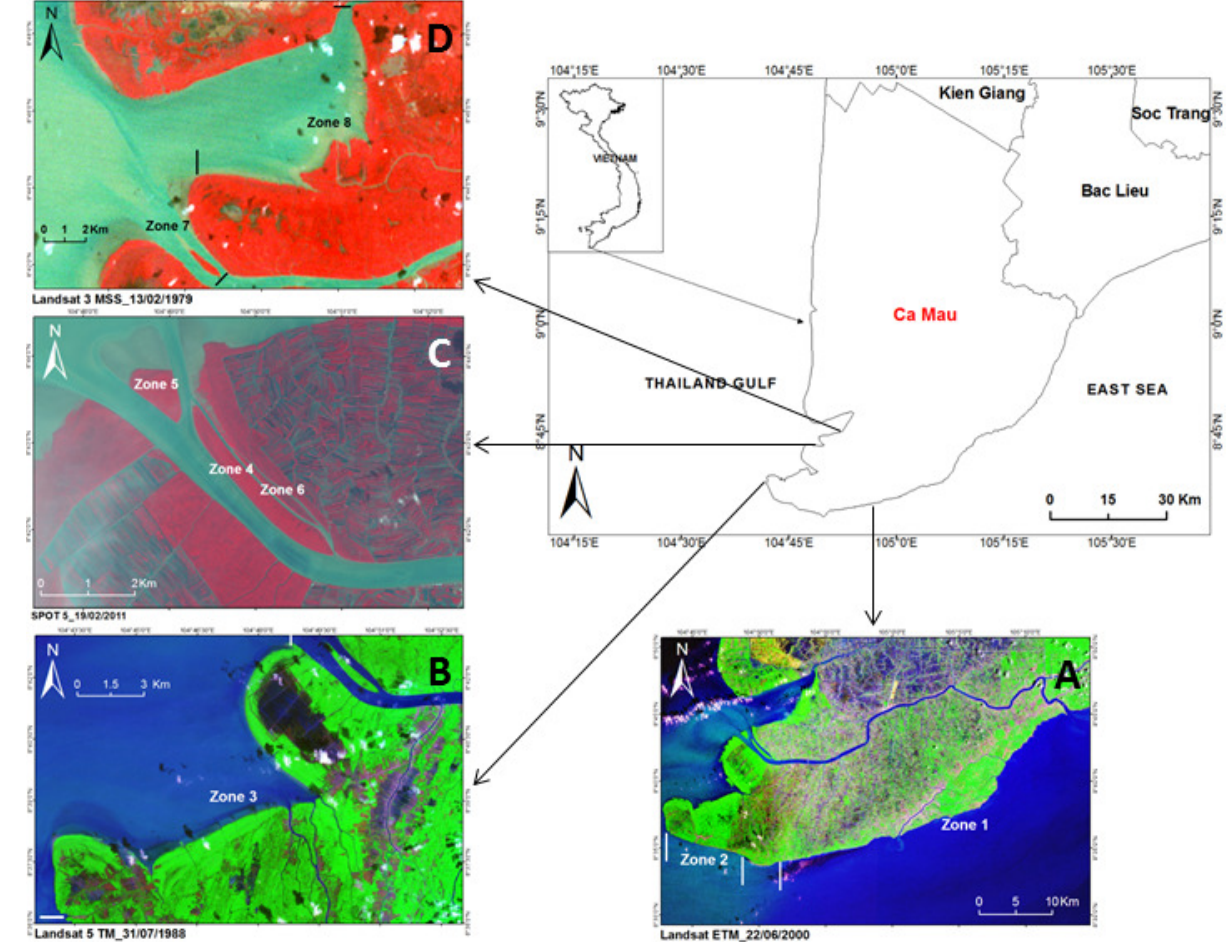
Figure 1. Map of the study area. It is divided into eight zones that depend on coastal characteristics and availability of remotely sensed data. (A) zones 1 and 2; (B) zone 3; (C) zones 4, 5 and 6; and (D) zones 7 and 8.